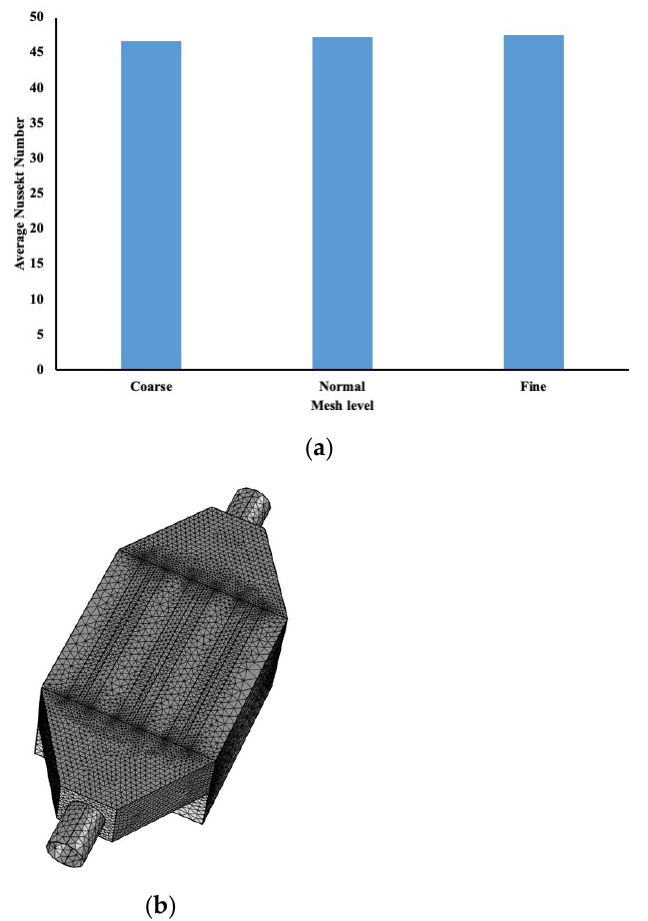
Figure 3. Finite element analysis . ( a ) Mesh sensitivity analysis, ( b ) Finite element model. Table 1. Mesh information for different levels of meshing.